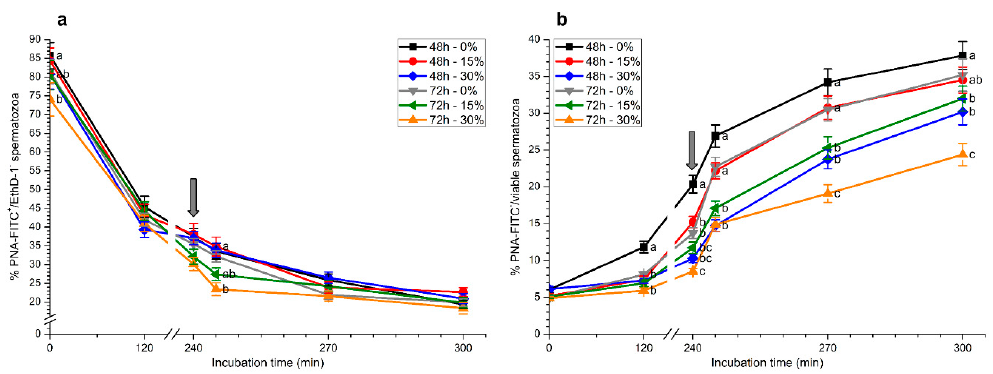
Figure 3. Percentages of viable spermatozoa with an intact acrosome (PNA-FITC + / EthD-1 − ; ( a )) and with an exocytosed acrosome (PNA − ) in relation to total viable spermatozoa ( b ) during in vitro capacitation and progesterone-induced acrosomal exocytosis (300 min) after previous storage of spermatozoa at 17 ◦ C with di ff erent concentrations of seminal plasma (0%, 15%, and 30%) for 48 h or 72 h. Grey arrow indicates the time at which 10 µ g / mL progesterone was added to induce acrosomal exocytosis (i.e., 240 min). Di ff erent letters mean significant ( p < 0.05) di ff erences between treatments at a given time point. Data are shown as mean ± SEM for seven independent